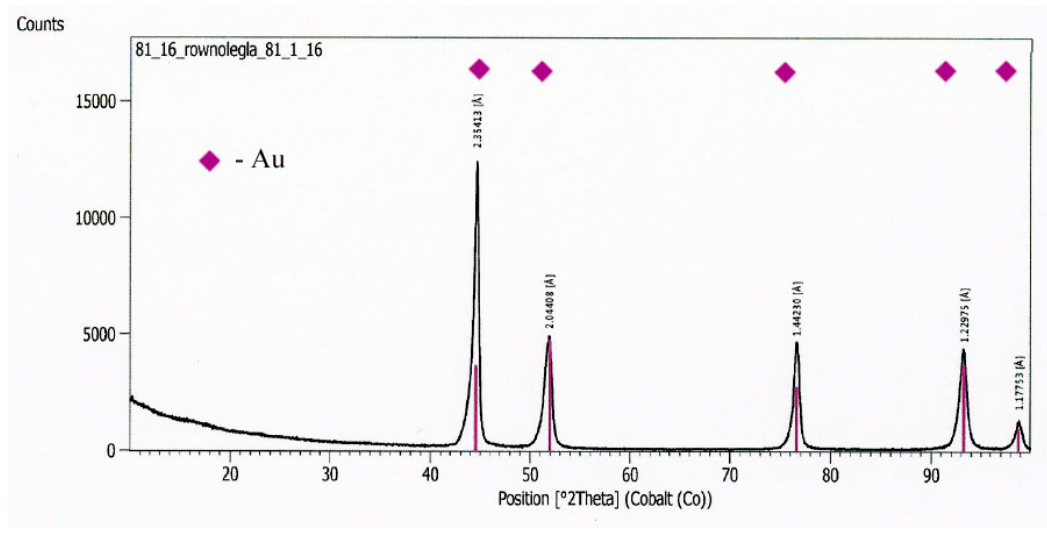
Figure 13. A di ff ractogram from the Au electrode